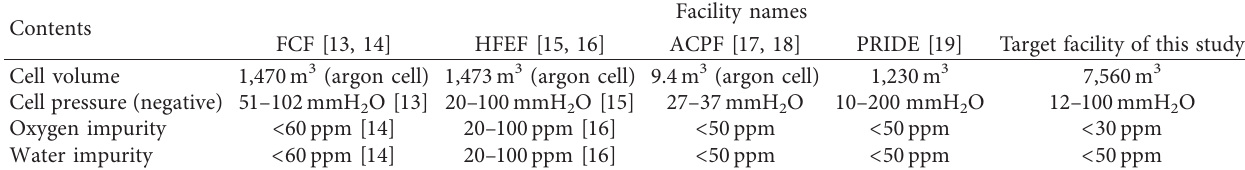
Table 1: Comparison of specifications among experimental hot cells and gas-tight cells